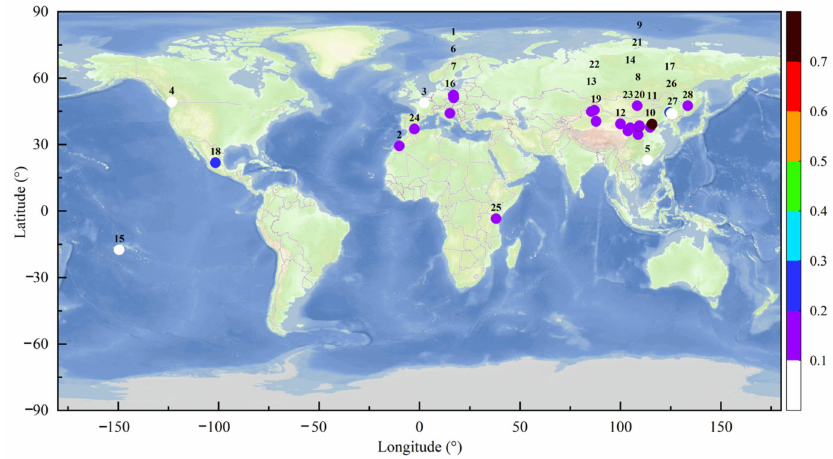
Figure 2. Daily dew intensity (mm) at other reported sites. 1. [42] (Poznan, Poland); 2. [43] (Mir- left, Morocco); 3. [15] (Paris, France); 4. [41] (Vancouver, Canada); 5. [24] (Guangzhou,